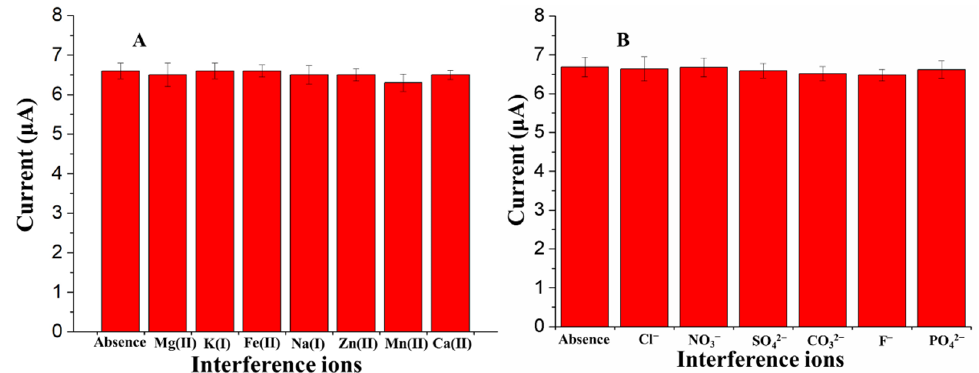
Figure 8. The selectivity of the proposed sensor in the presence of high concentrations of different ions ( A : Cation; B : Anion) on the stripping peak current of 50 μg/L As(III) at Fe 3 O 4 -Au-IL/GCE in 0.2 M acetate buffer (pH 5.0). Each data point is an average of 5 measurements from 3 electrodes and error bars represent ±1 standard deviation.